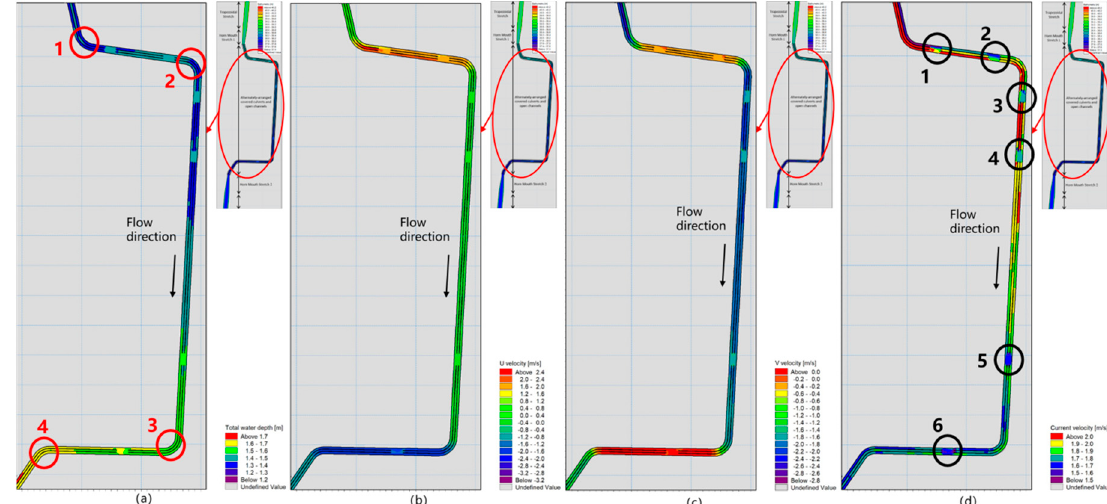
Figure 5. Hydraulic factors map in the culverts and open channels (simulation scenario 1). ( a ) Water depth map; ( b ) Horizontal flow velocity; ( c ) Vertical flow velocity; ( d ) Current flow velocity.